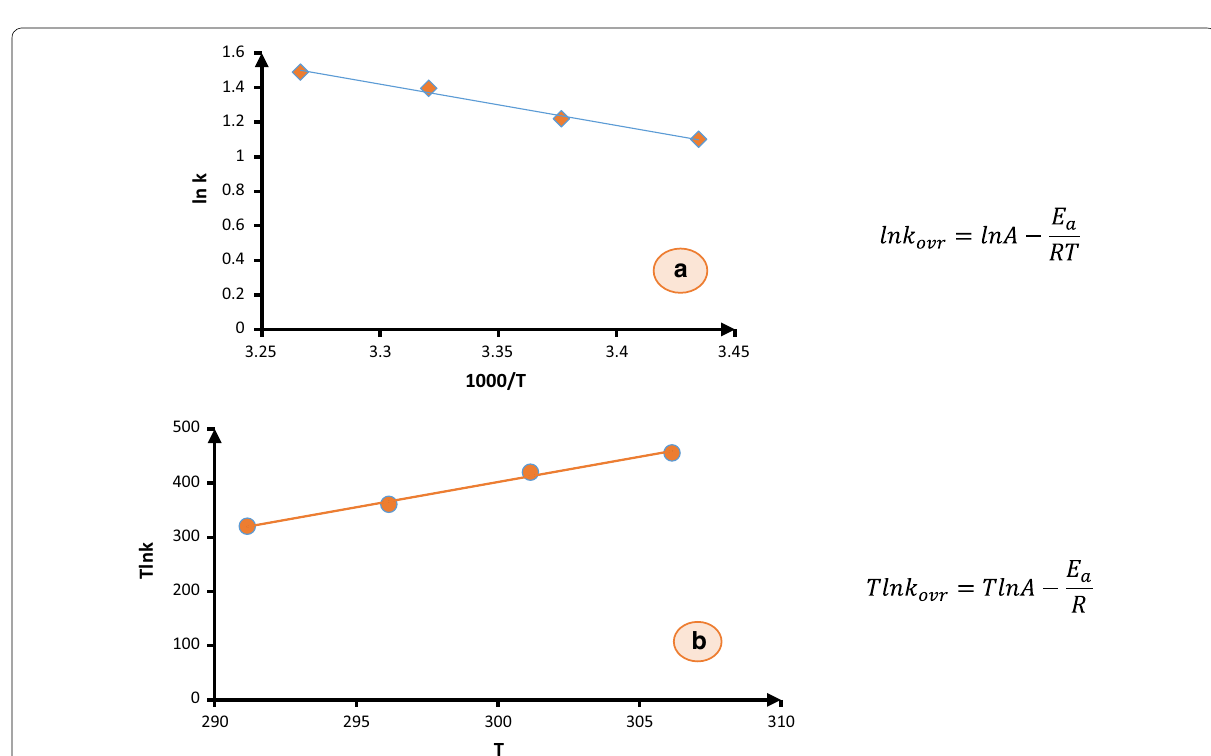
Fig. 6 a Dependence of second order rate constant ( lnk ovr against 1/T ) on reciprocal temperature for the reaction between reactants ( 1 ), ( 2 ) and ( N – H ) in methanol measured at wavelength of 305 nm in accordance with the Arrhenius equation for obtaining E a R from the slope. b A linearized form of Arrhenius equation (T lnk against T) in order to obtain ln A from the